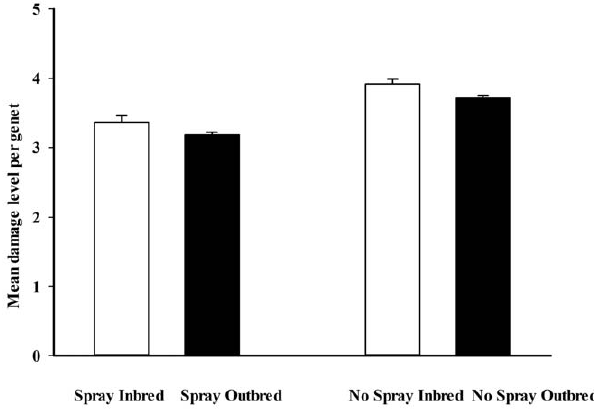
Figure 2. Mean + / 2 SE for the average amount of herbivore damage on each ramet per genet among inbred and outbred plants on spray (bi-weekly insecticide applications) and no spray fields during the second growing